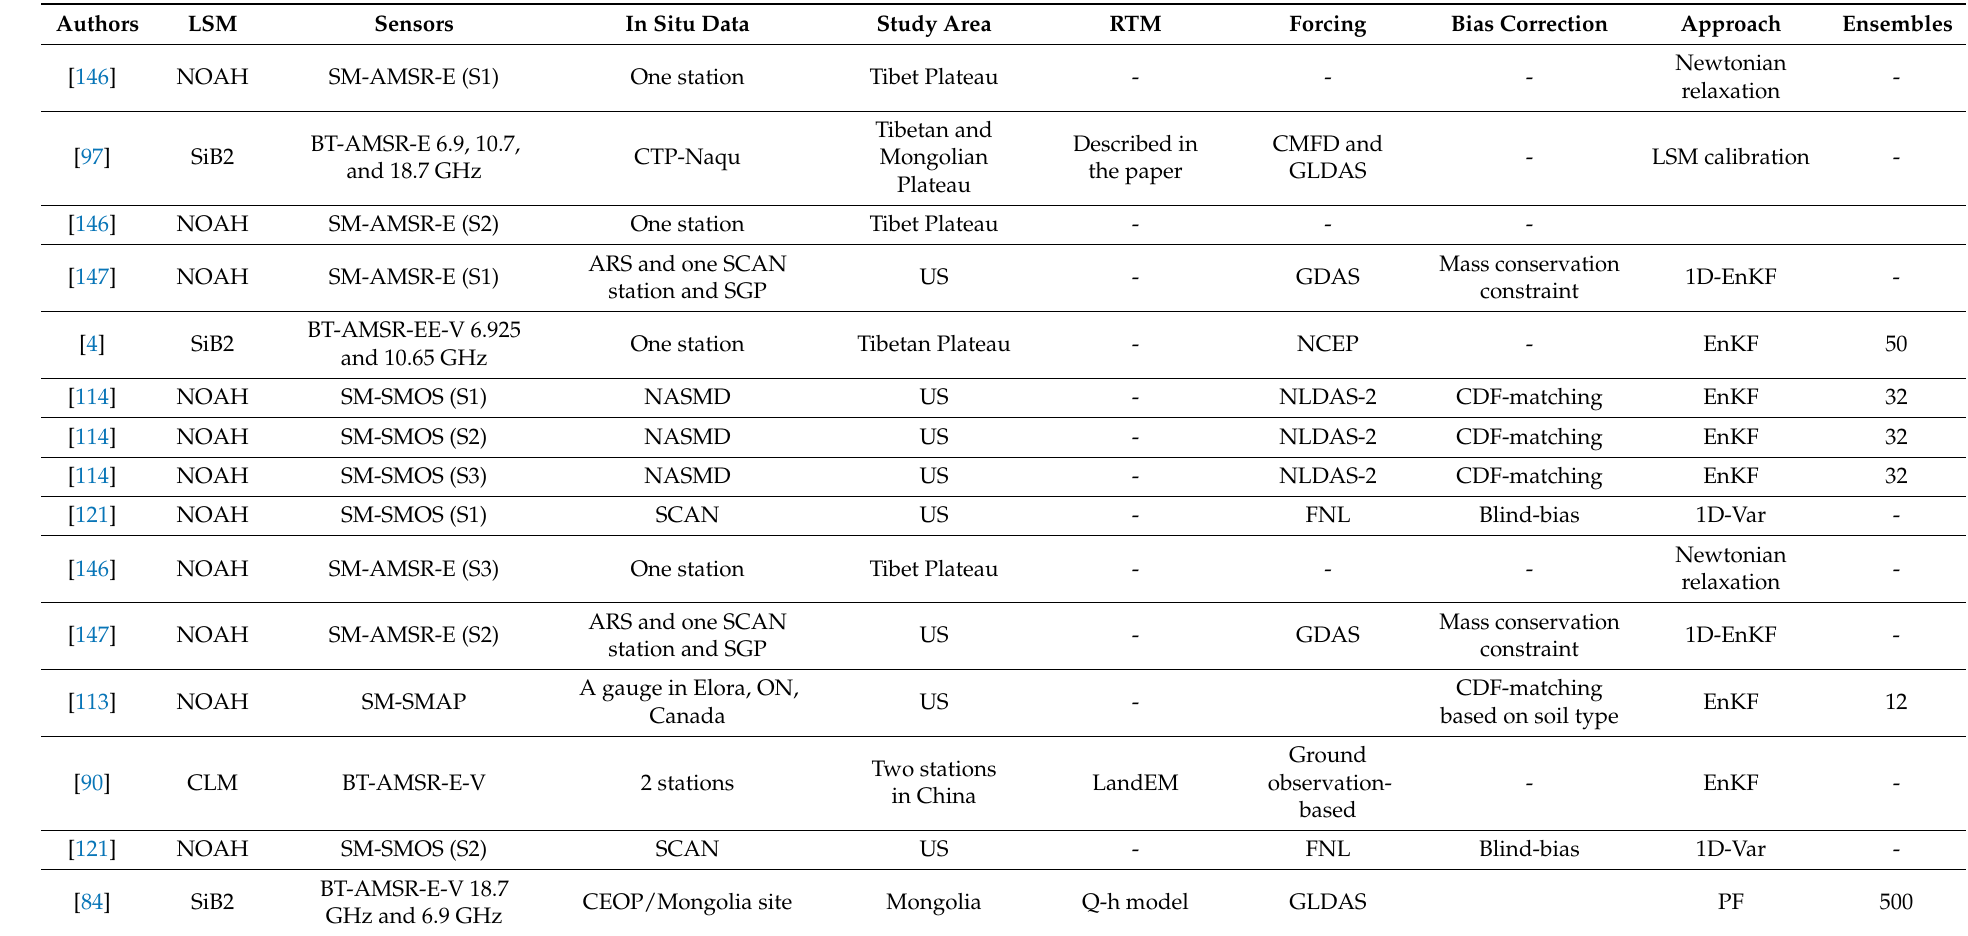
Table 4. RMSE improvements in SSM with RMSEs of less than − 0.024 (m3 m-3) for papers reviewed in this